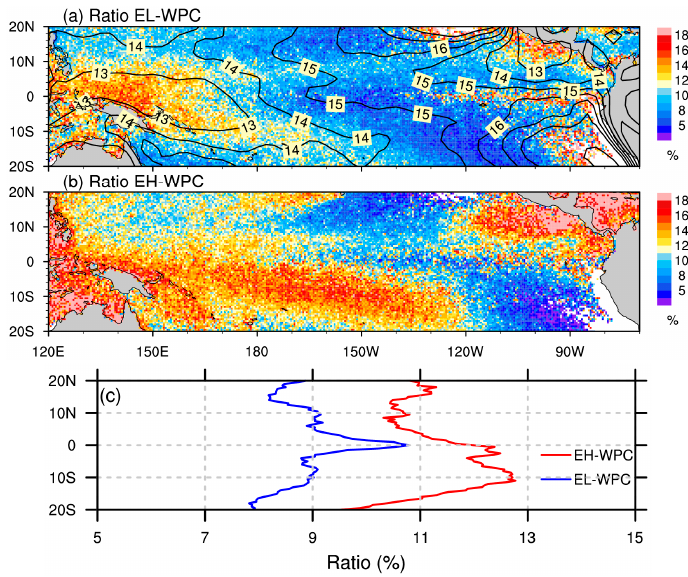
Figure 3. Distribution of the ratio (to total WPC) of ( a ) EL-WPC and ( b ) EH-WPC, as well as ( c ) their zonal means. The lower-tropospheric stability (contours; units: K) is overlapped on ( a ) and the surface wind (vectors; units: m s − 1 ) on ( b ).